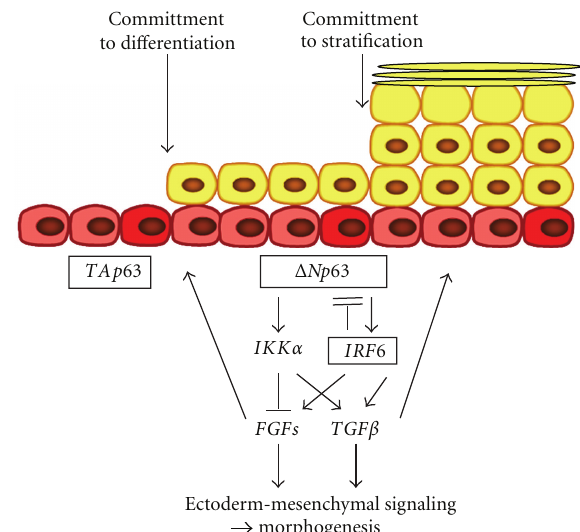
Figure 1: Schematic representation of known and proposed p63 pathways relevant for epidermal di ff erentiation, ectoderm-meso- derm signaling, and the onset of ectodermal dysplasias. p63 , IKK α , and IRF6 play a role in the developing epidermis, in a cell autonomous way to facilitate cell cycle arrest and di ff erentiation. The same molecules also regulate the expression of soluble factors such as TGF β and members of the FGF family to regulate the development of the underlying mesoderm, via epithelial-mesen- chymal signaling. Disease genes are framed in boxes; regula- tions/interactions are indicated with lines or